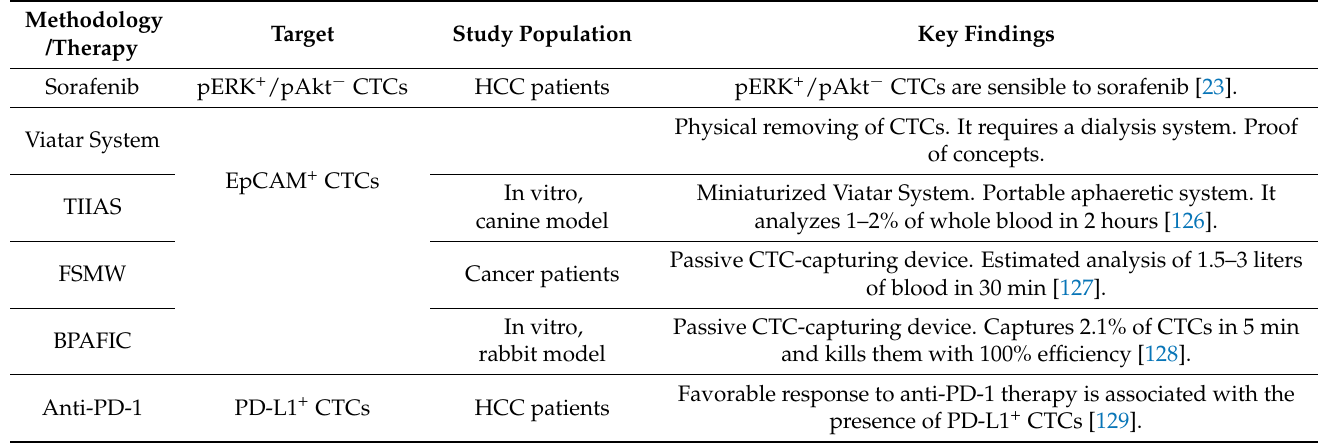
Table 1. Potential strategies to target CTCs or tumor microenvironment to prevent HCC recurrence and metastases. The table includes systemic treatments, physical removal methods, and strategies based on gene therapy and